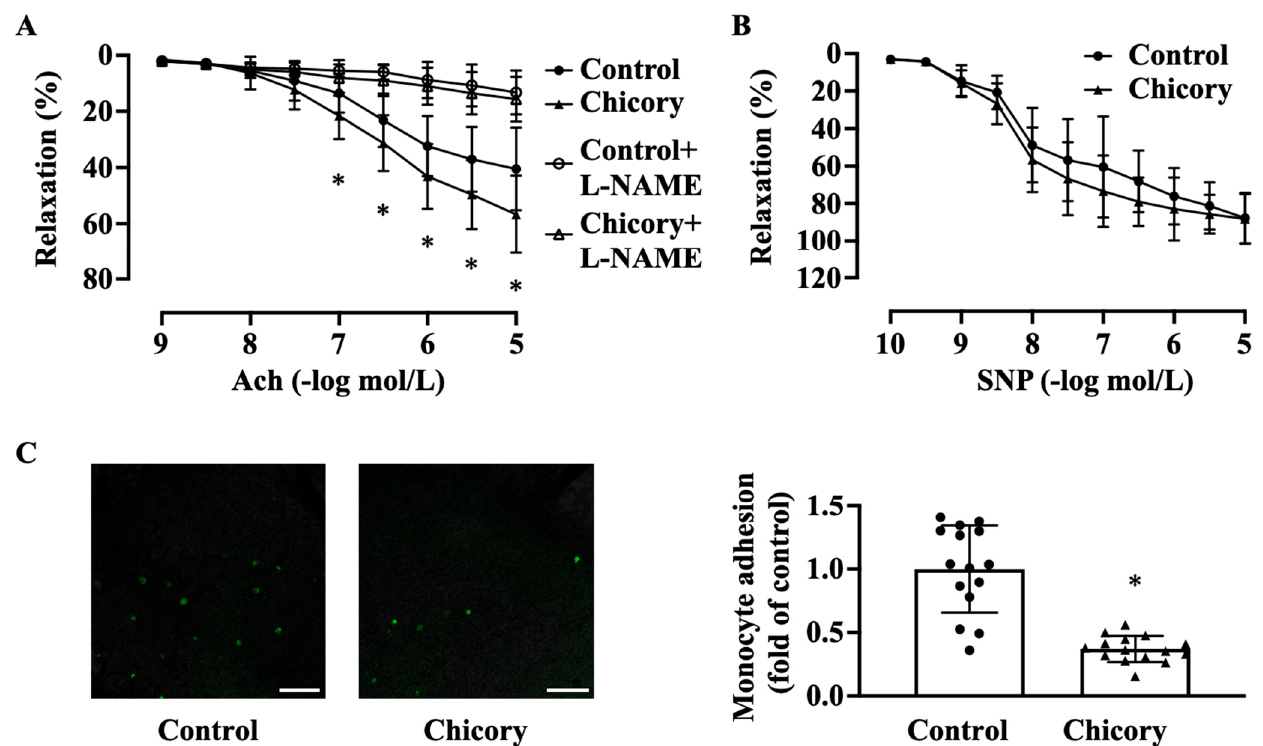
Figure 3. Brussels chicory consumption improves aortic endothelial-dependent relaxation and inhibits monocyte adhesion to aortic endothelium in Apoe − / − mice. ( A ) Thoracic aortic endothelial dependent relaxation in response to acetylcholine (Ach) in the presence or absence of N ω -nitro-L- arginine methyl ester (L-NAME). ( B ) Thoracic aortic endothelial-independent relaxation in response to sodium nitroprusside (SNP). ( C ) Representative images (left panel) and quantification (right panel) of the adhesion of green fluorescent calcein-labeled HL-60 monocytes to the isolated endothelium of ascending aortas. Scale bars: 250 μ m. Data are presented as means ± SD. n = 15. * Significantly different from the control group ( p < 0.05). Apoe, apolipoprotein E; Chicory, Brussels chicory.